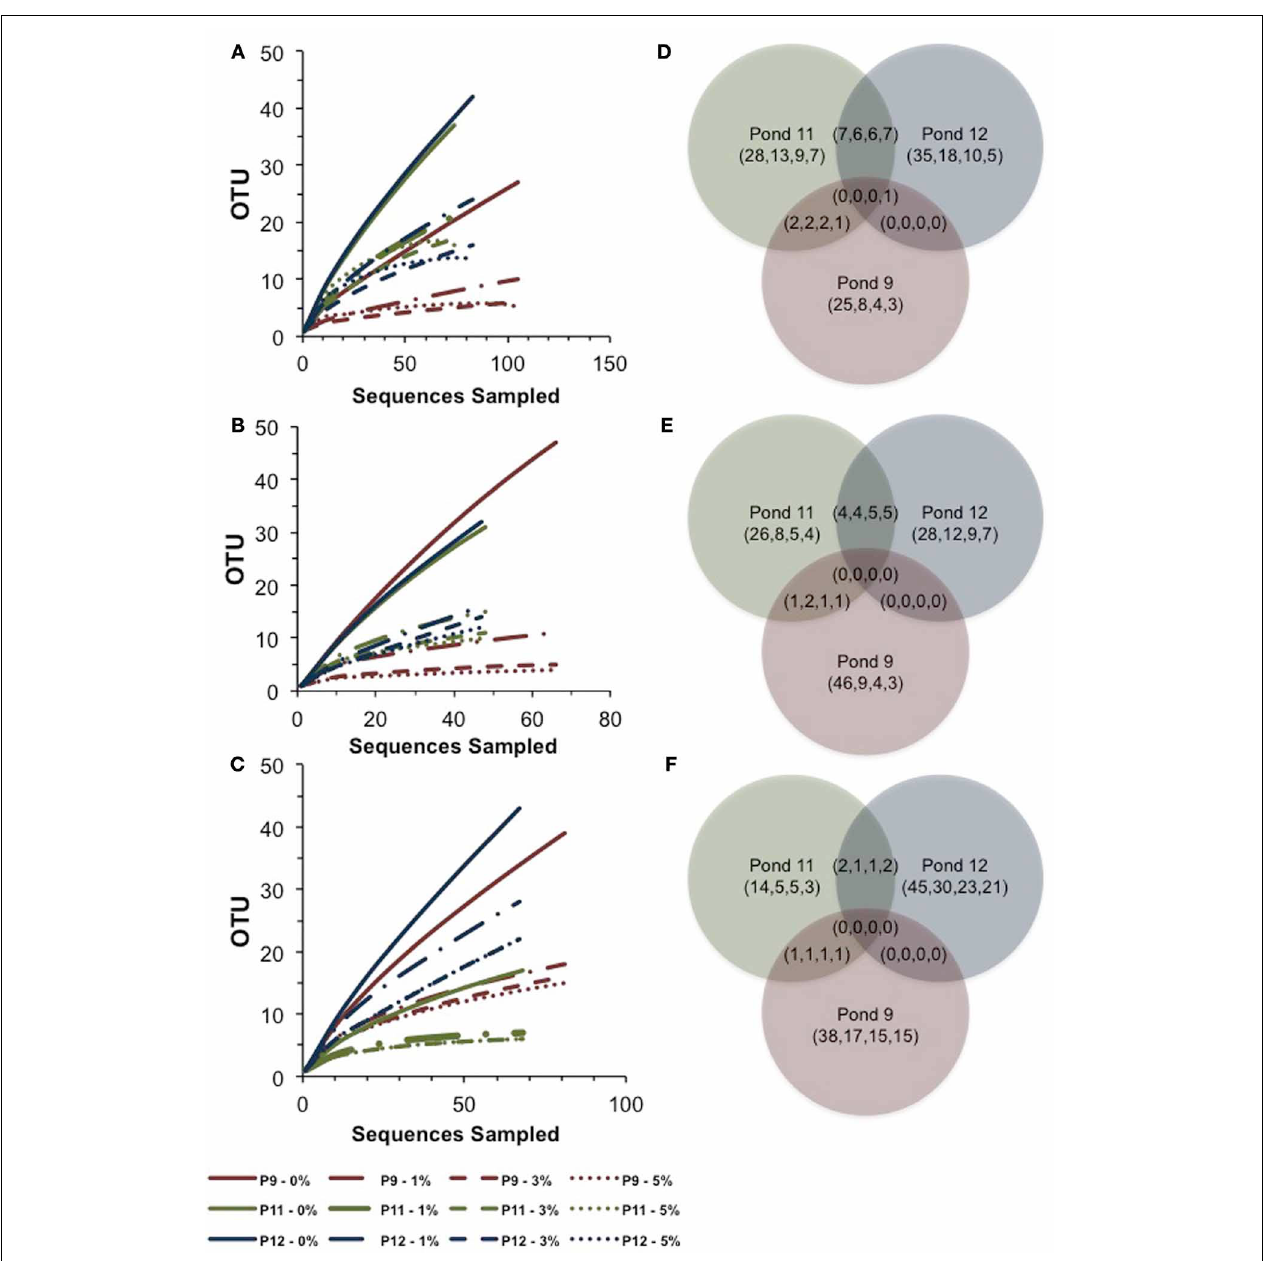
FIGURE 3 | Rarefaction curves and Venn diagrams showing the shared and unique OTUs across Ponds for archaeal 16S rRNA genes (A,D), bop genes (B,E), and bacterial 16S rRNA genes (C,F). Pond 9 results are shown